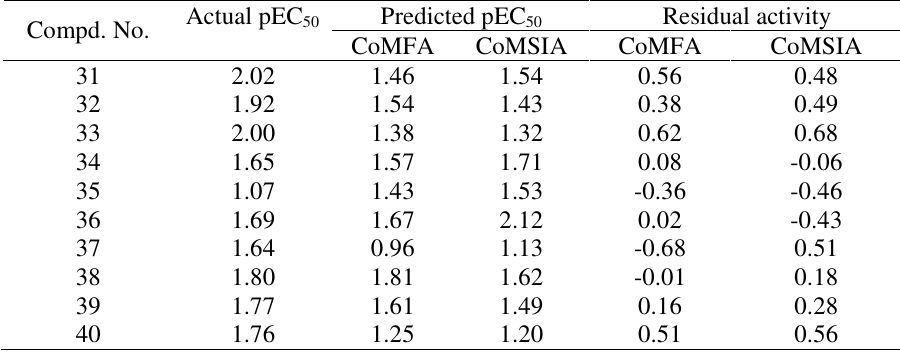
Table 4 . Experimental and predicted inhibitory activities of compounds in test